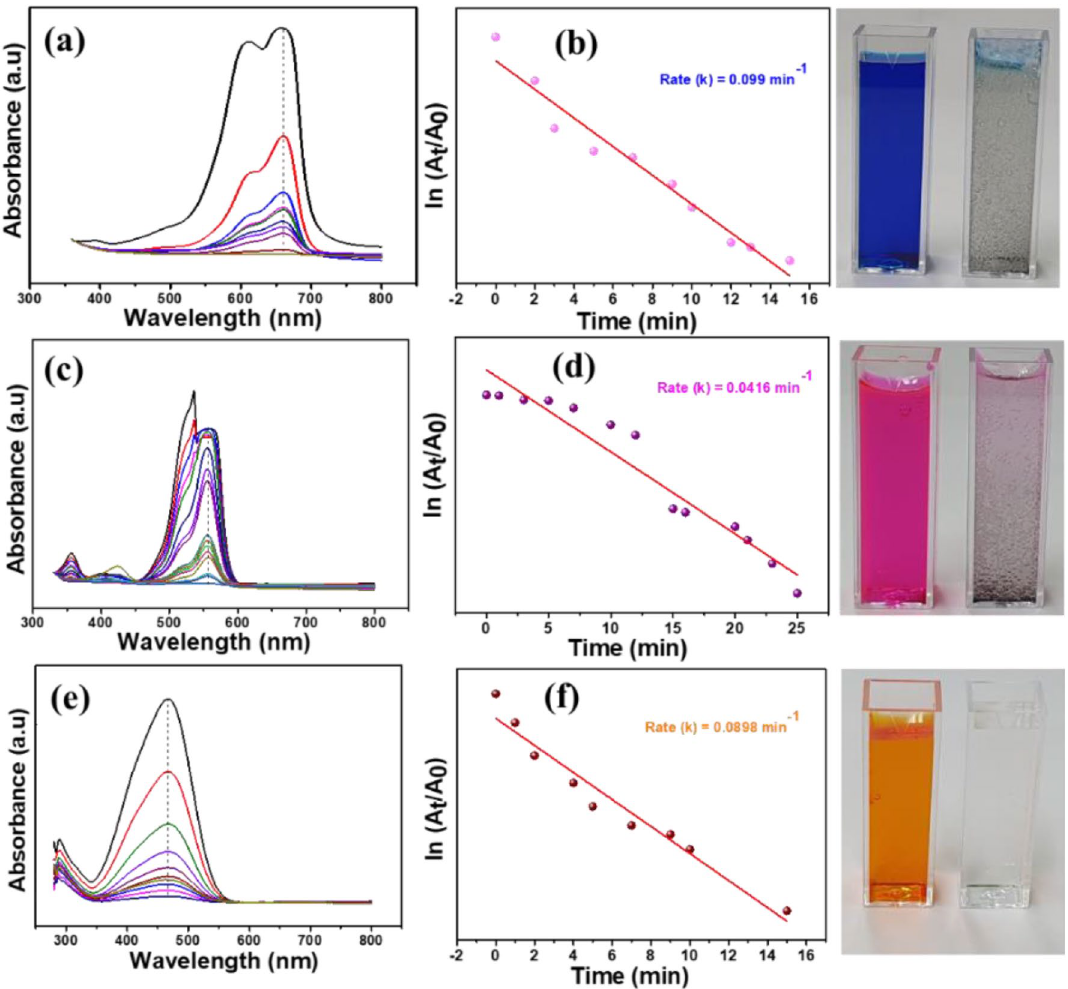
Figure 9. Catalytic activity and kinetic rate of PdO–NiO nanocomposite on reduction of azo dyes with NaBH 4 solution ( a , b ) MB, ( c , d ) RhB and ( e , f ) MO.